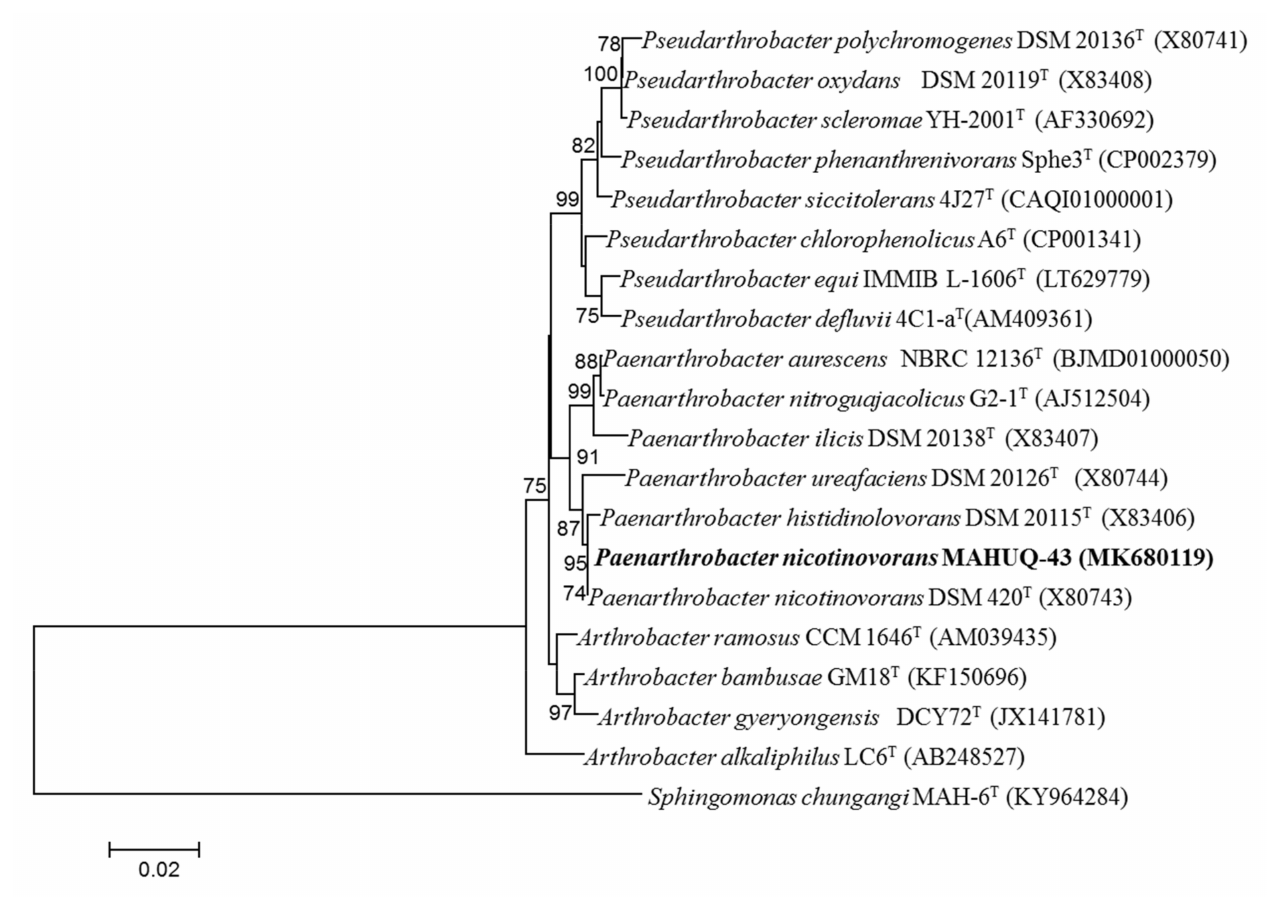
Figure 1. The neighbor-joining (NJ) tree based on 16S rRNA gene sequence analysis showing phylogenetic relationships of strain MAHUQ-43 T and the related type strains. Bootstrap values more than 70% based on 1000 replications are shown at branching points. Scale bar, 0.02 substitutions per nucleotide